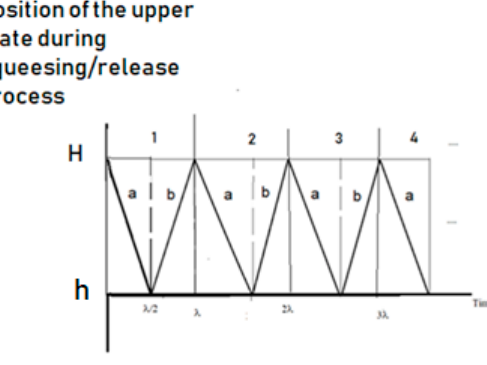
Figure 3. Graphical representation of the compression/decompression process of the foam production of the device shown in Figure 1 where a—compression stage and b—decompression